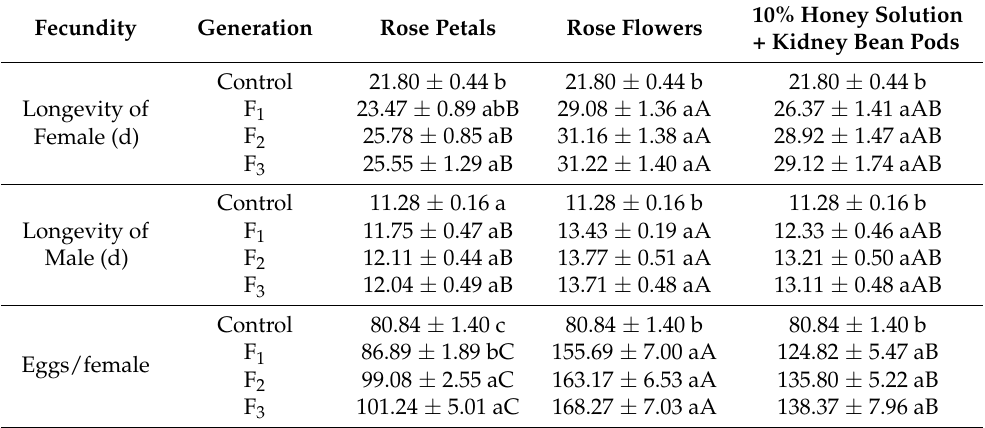
Table 2. The effect of different food types on adult F. occidentalis longevity and reproduction. 10% Honey Solution Fecundity Generation Rose Petals Rose Flowers + Kidney Bean Pods Control 21.80 ± 0.44 b 21.80 ± 0.44 b 21.80 ± 0.44 b F 1 23.47 ± 0.89 abB 29.08 ± 1.36 aA 26.37 ± 1.41 aAB Longevity of F 2 25.78 ± 0.85 aB 31.16 ± 1.38 aA 28.92 ± 1.47 aAB Female (d) F 3 25.55 ± 1.29 aB 31.22 ± 1.40 aA 29.12 ± 1.74 aAB Control 11.28 ± 0.16 a 11.28 ± 0.16 b 11.28 ± 0.16 b F 1 11.75 ± 0.47 aB 13.43 ± 0.19 aA 12.33 ± 0.46 aAB Longevity of Male (d) 12.04 ± 0.49 aB 13.71 ± 0.48 aA 13.11 ± 0.48 aAB Control 80.84 ± 1.40 c 80.84 ± 1.40 b 80.84 ± 1.40 b F 1 86.89 ± 1.89 bC 155.69 ± 7.00 aA 124.82 ± 5.47 aB Eggs/female F 2 99.08 ± 2.55 aC 163.17 ± 6.53 aA 135.80 ± 5.22 aB F 3 101.24 ± 5.01 aC 168.27 ± 7.03 aA 138.37 ± 7.96